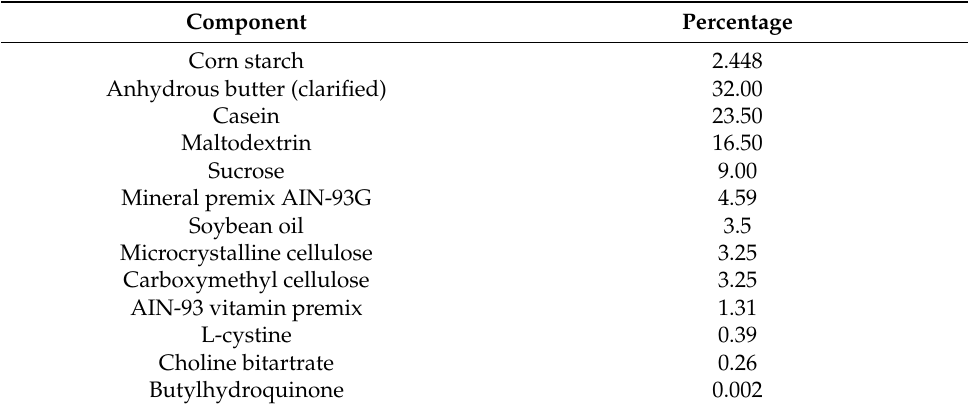
Table 3. Distribution of components of the hypercaloric diet.